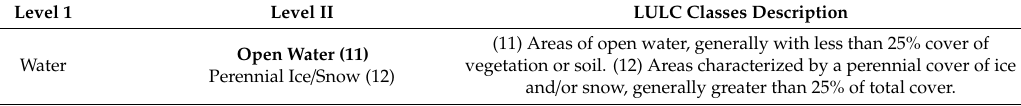
Table A1. Description of LULC classes. The text and numbers in bold highlight the name and code of THE LULC classes used in the